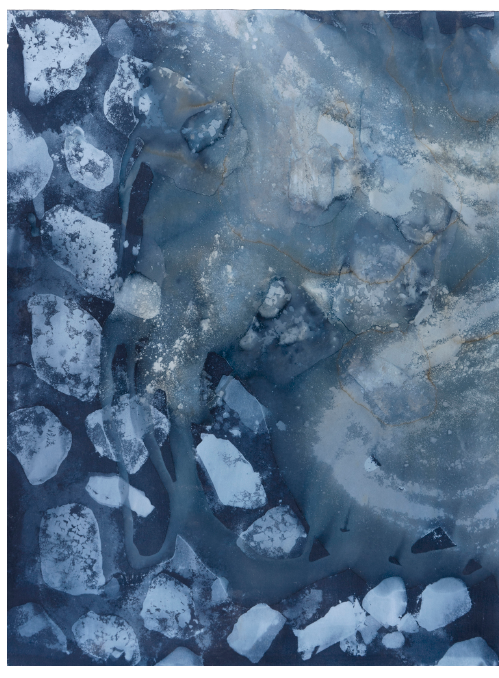
Figure 1: Downwaste (Siyeh I), 2017. Cyanotype on paper, 30" x 22". Courtesy of Jonathan Marquis. Downwaste gallery available at: